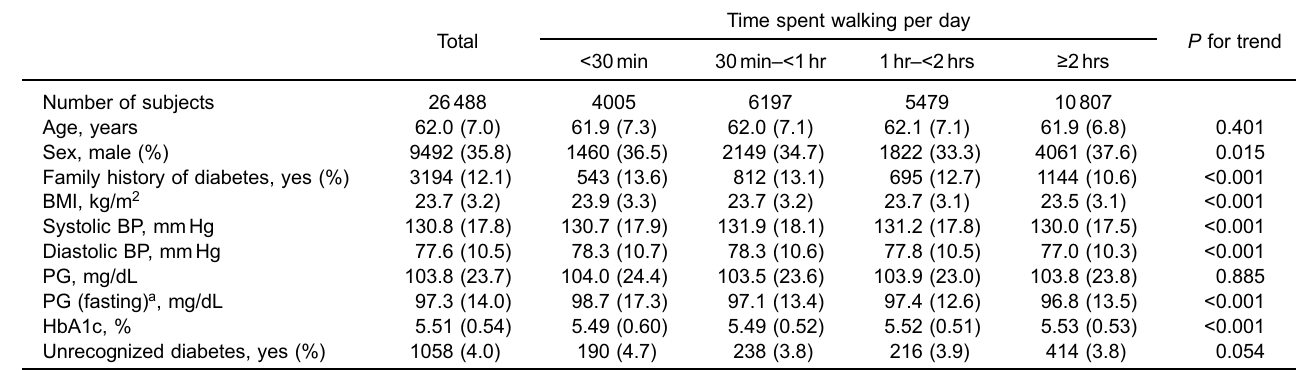
Table 1. Characteristics of study participants according to time spent walking per day (cross-sectional analysis) Time spent walking per Total